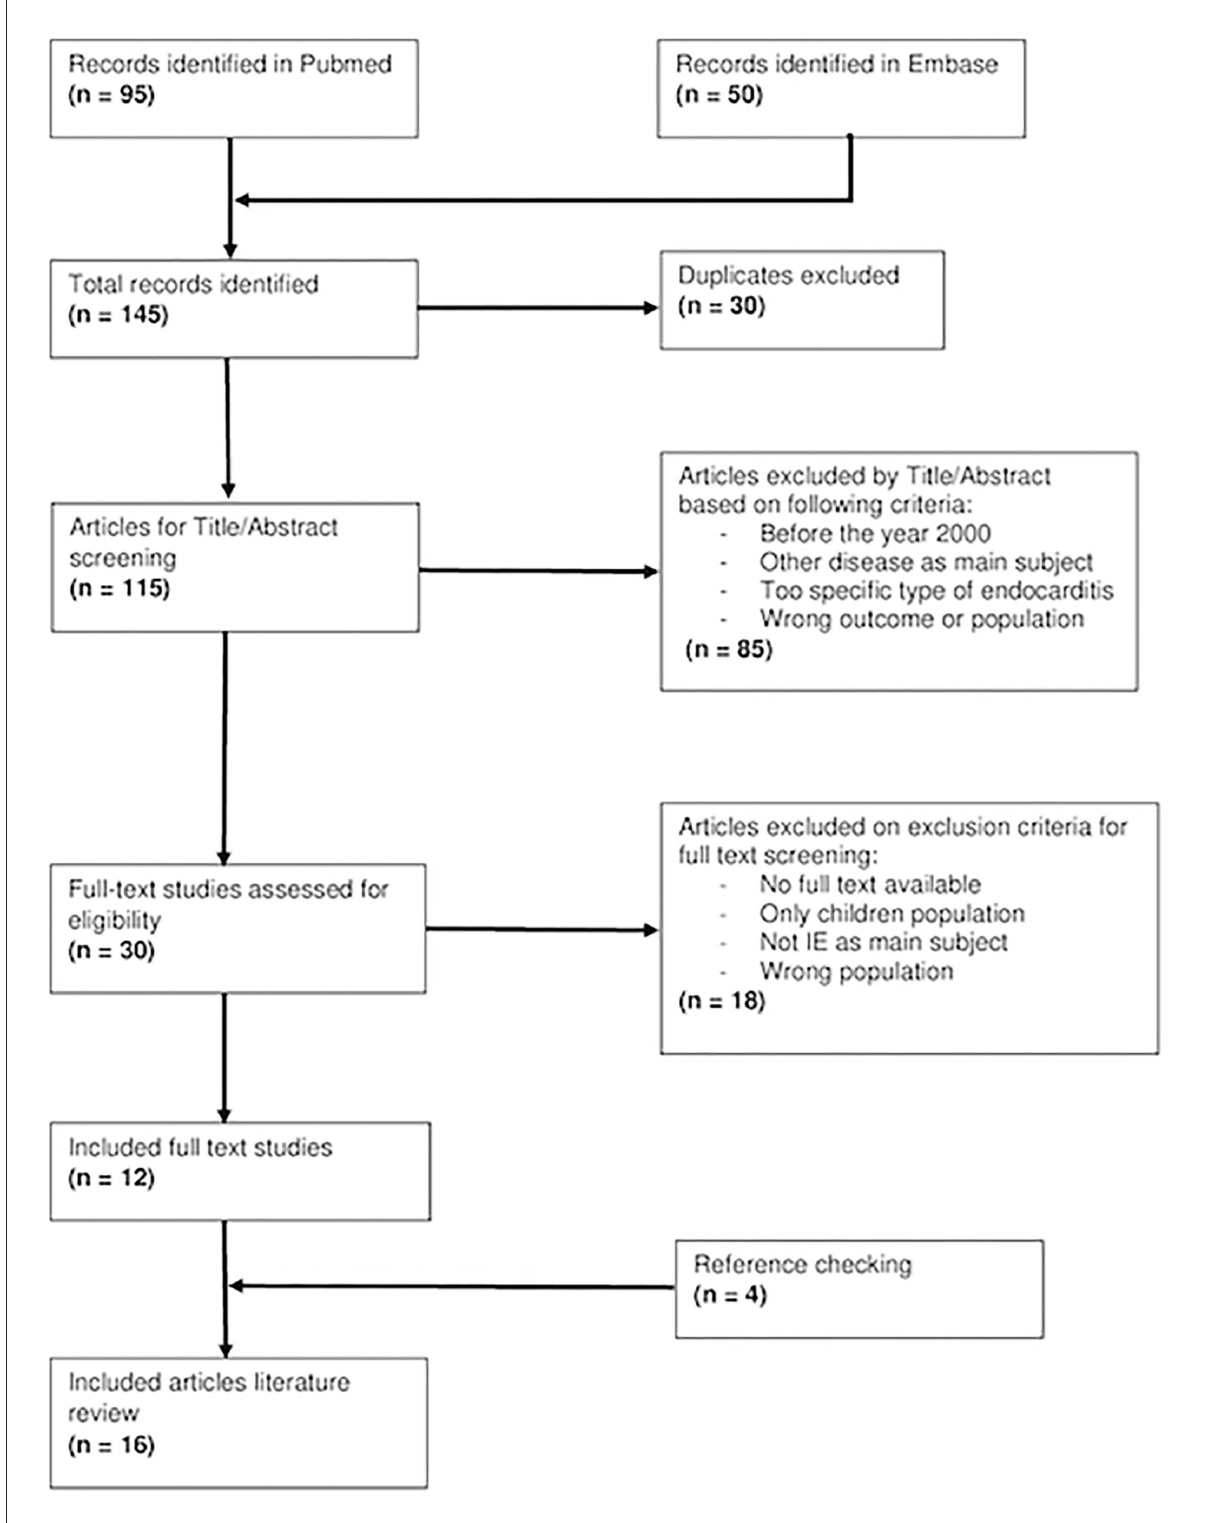
FIGURE1 A flowchart showing a literature search of included